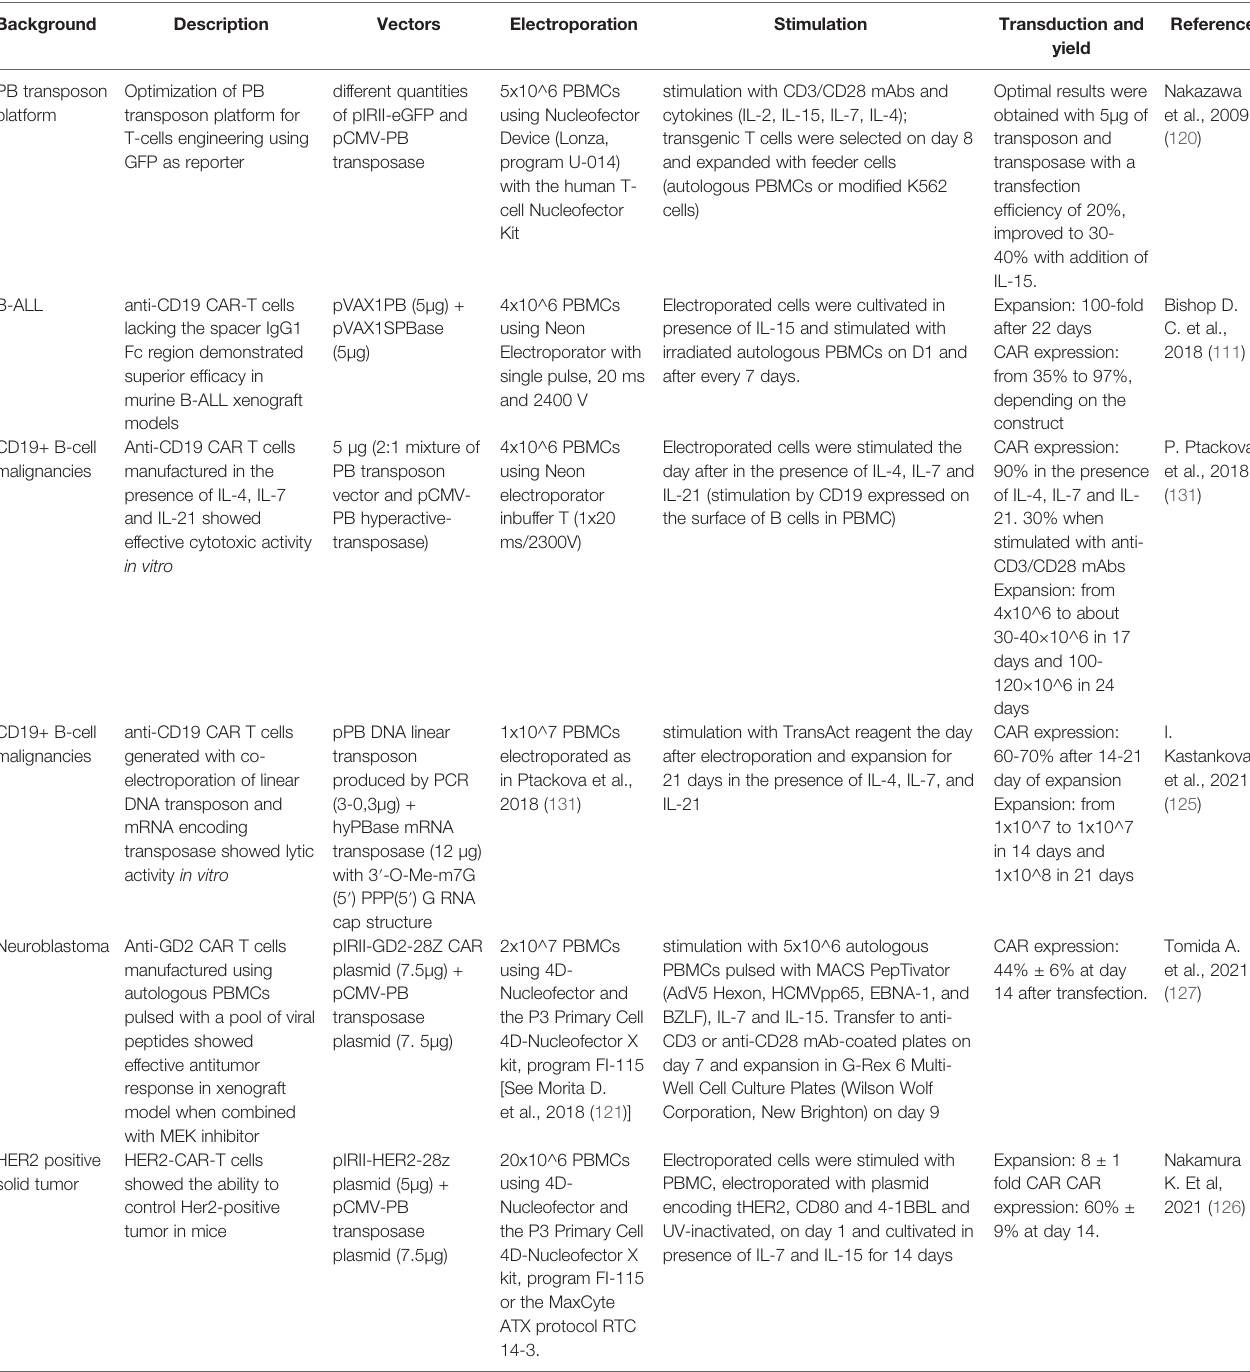
TABLE 3 | Manufacturing protocols associated with preclinical studies employing PB in the context of CAR T